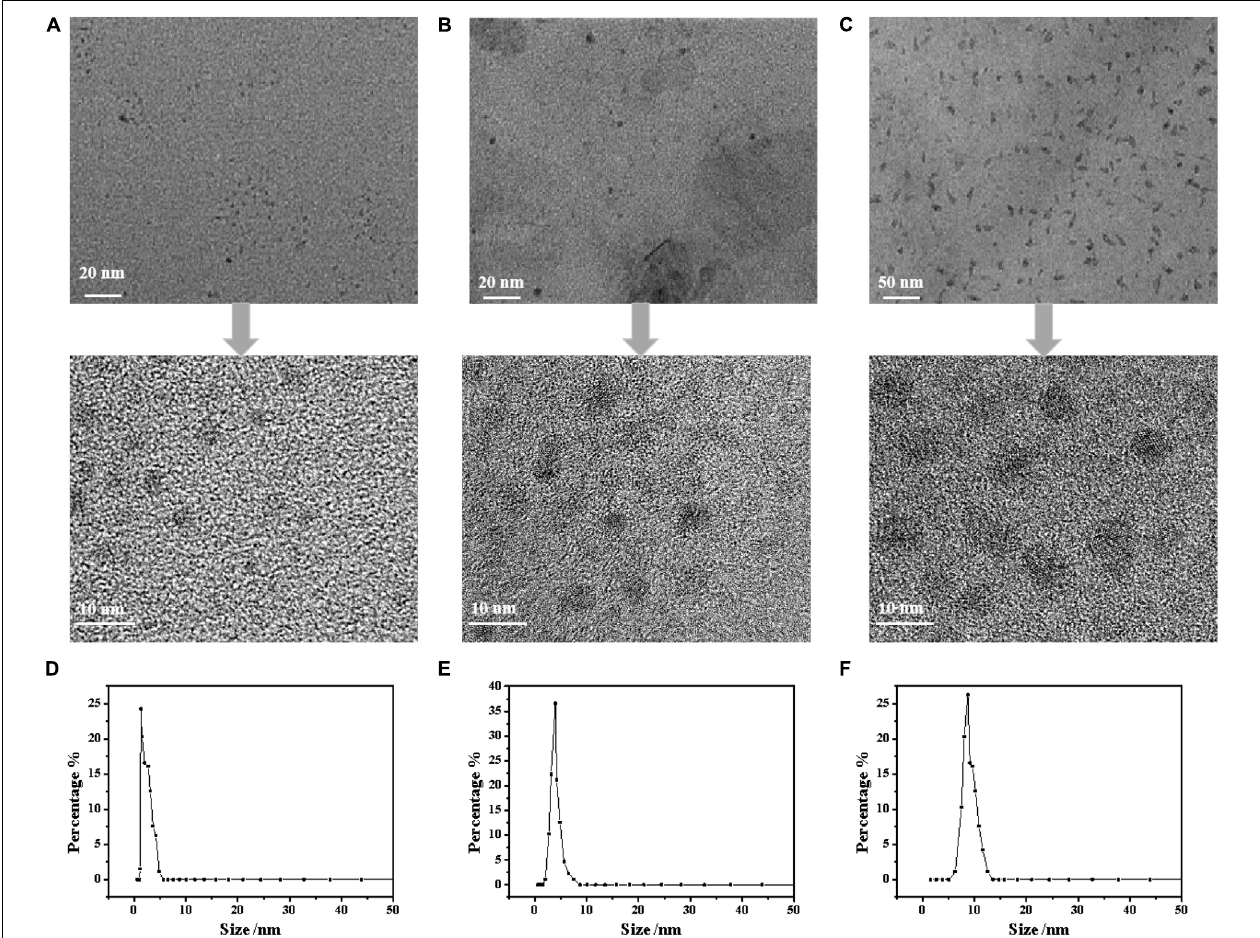
FIGURE 2 | The TEM images of CDs-4: (A) CDs-4a; (B) CDs-4b, and (C) CDs-4c. And the particle size of CDs-4: (D) CDs-4a; (E) CDs-4b, and (F) CDs-4c.